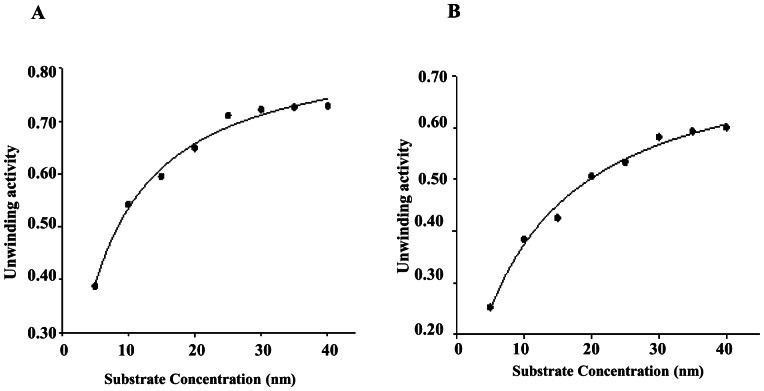
Kinetics of helicase activity.A. sUD and B. sUDN1N2. Helicase assay reactions were performed using different concentrations of substrate and keeping constant concentration of sUD and sUDN1N2. Km and Vmax values were calculated from the plot.